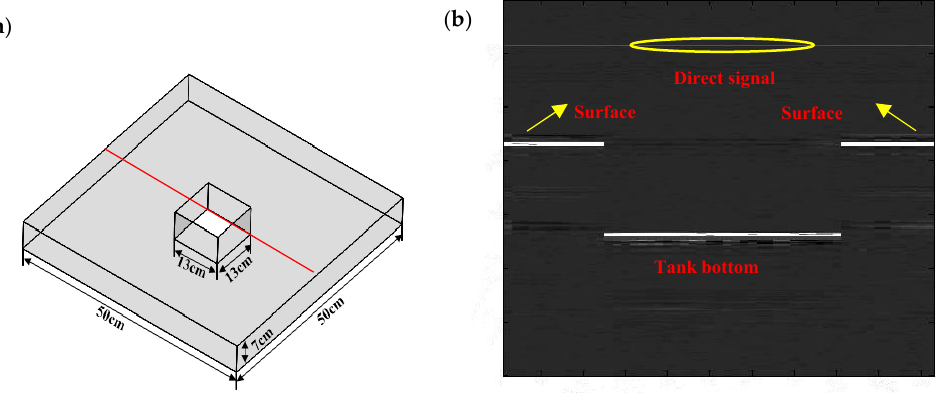
Figure 8. ( a ) Physical models; ( b ) lateral imaging of the physical models.